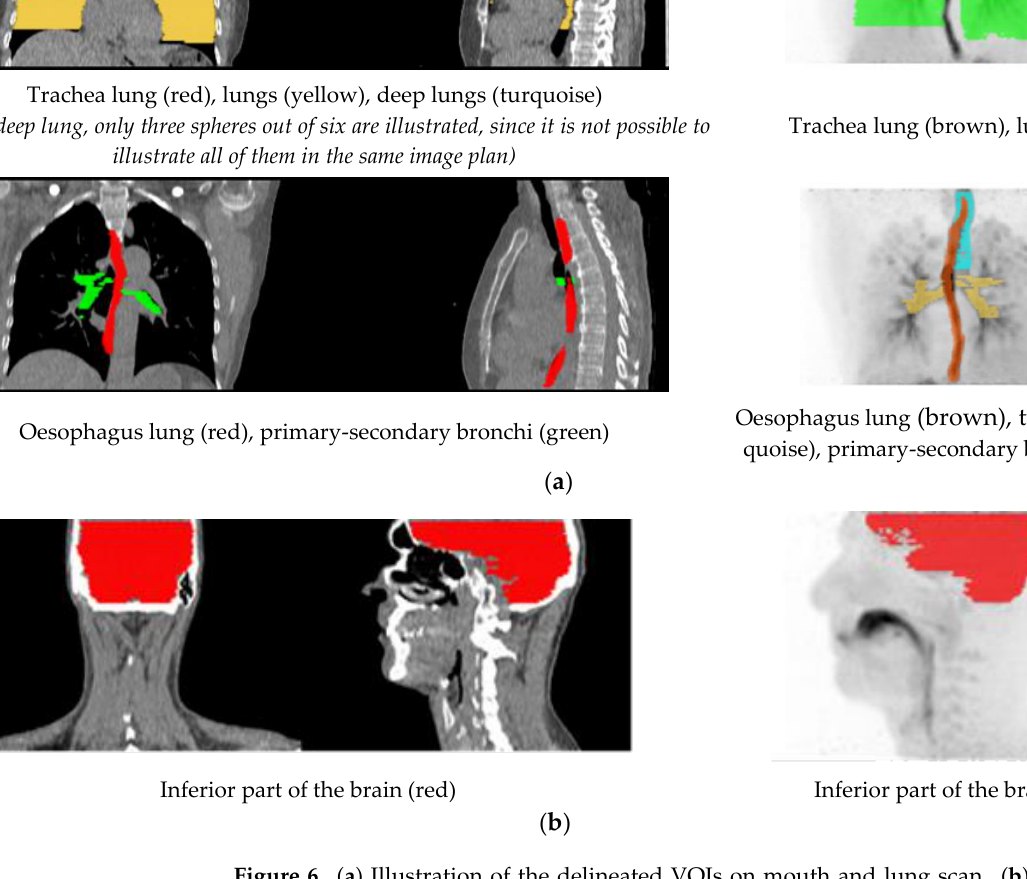
Figure 6. ( a ) Illustration of the delineated VOIs on mouth and lung scan. ( b ) Illustration of the delineated VOIs on inferior part of the brain.